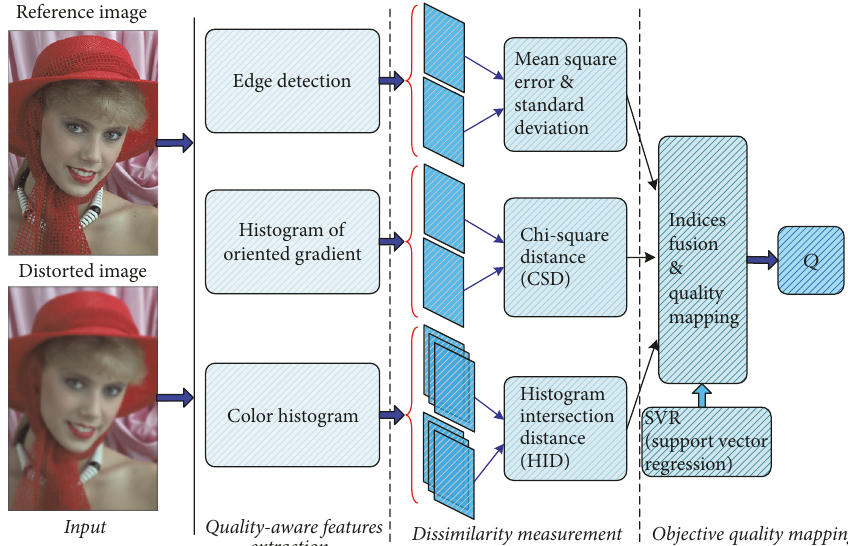
Figure 1: Framework of the proposed